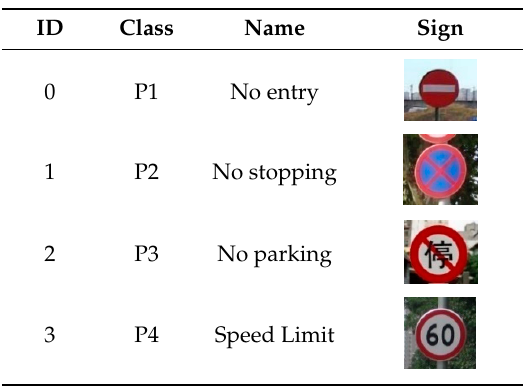
Table 1. Taiwan’s Prohibitory Signs.